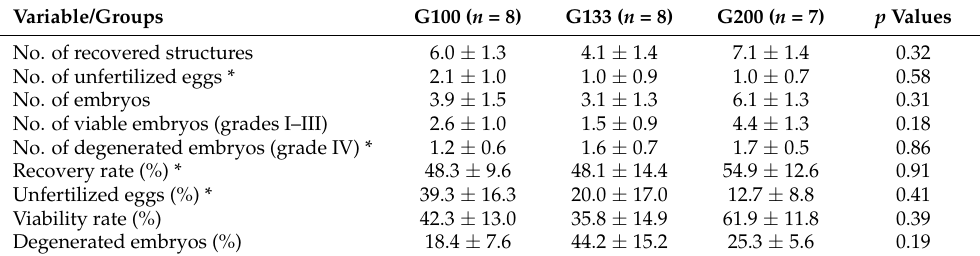
Table 4. Embryo yields (per donor ewe) in Santa In ê s ewes that underwent hormonal ovarian superstimulation with different total doses of pFSH (mean ±